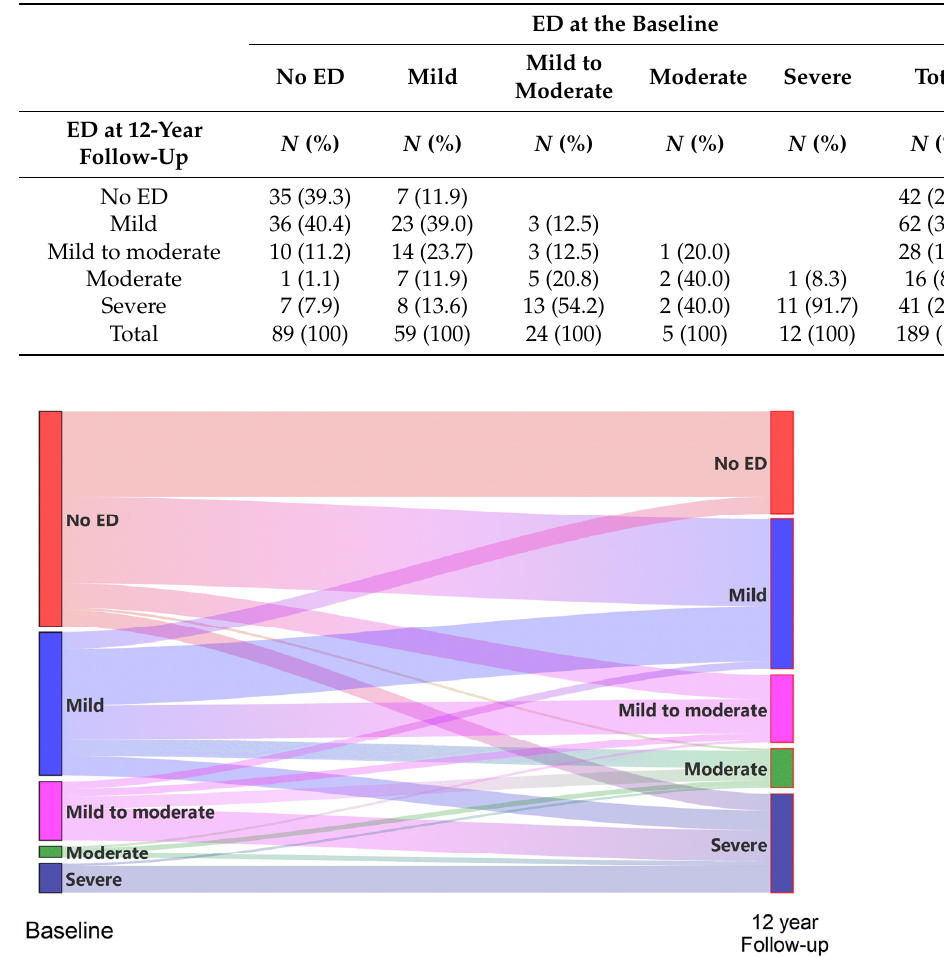
Figure 3. Changes in erectile function flow and changes according to the IIEF-5 during the 12-year follow-up period.